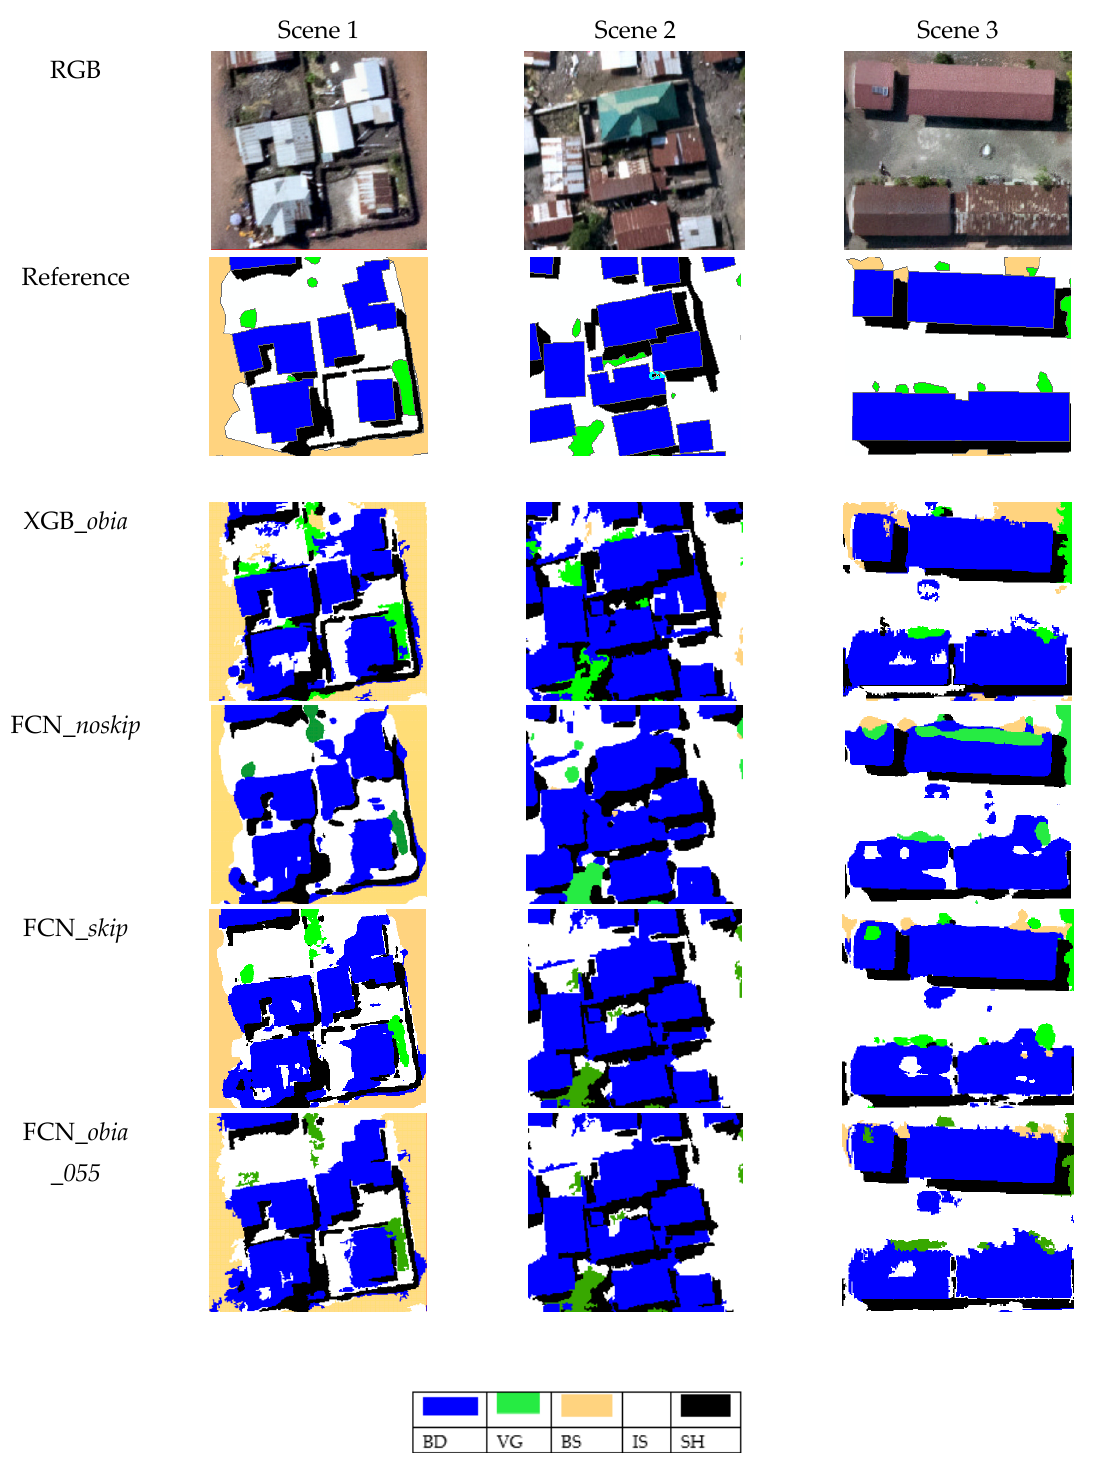
Figure 7. Classification maps of sample scenes for XGB _obia , FCN _noskip , FCN _skip and FCN _obia methods. BD-Building, VG- Vegetation, BS- Bare Soil, IS- Impervious surfaces, SH- Shadows